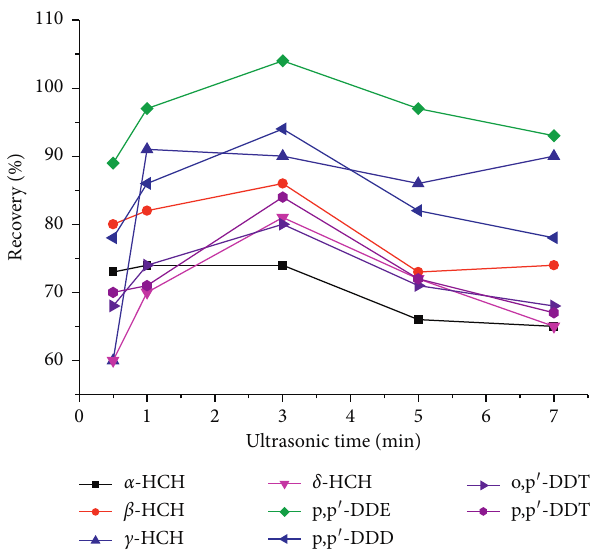
Figure 4: Selection of ultrasonic